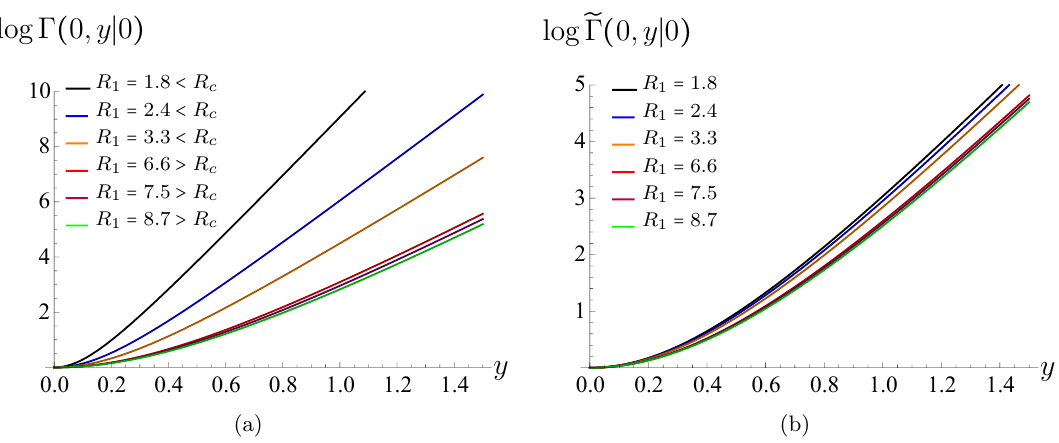
Figure 7 . The y dependence of the Bethe-Salpeter wavefunction from numerical solution of the Dyson equation for various values of R 1 . The other parameters are set to h = 0, R 2 = 1 and g = 10: (a) for loops of opposite orientation and (cid:13) = 0. For these values of parameters the Gross-Ooguri p transition happens at R c = 3 + 2 2 ’ 5 : 83; (b) for loops of the same orientation and (cid:13) = (cid:25)=